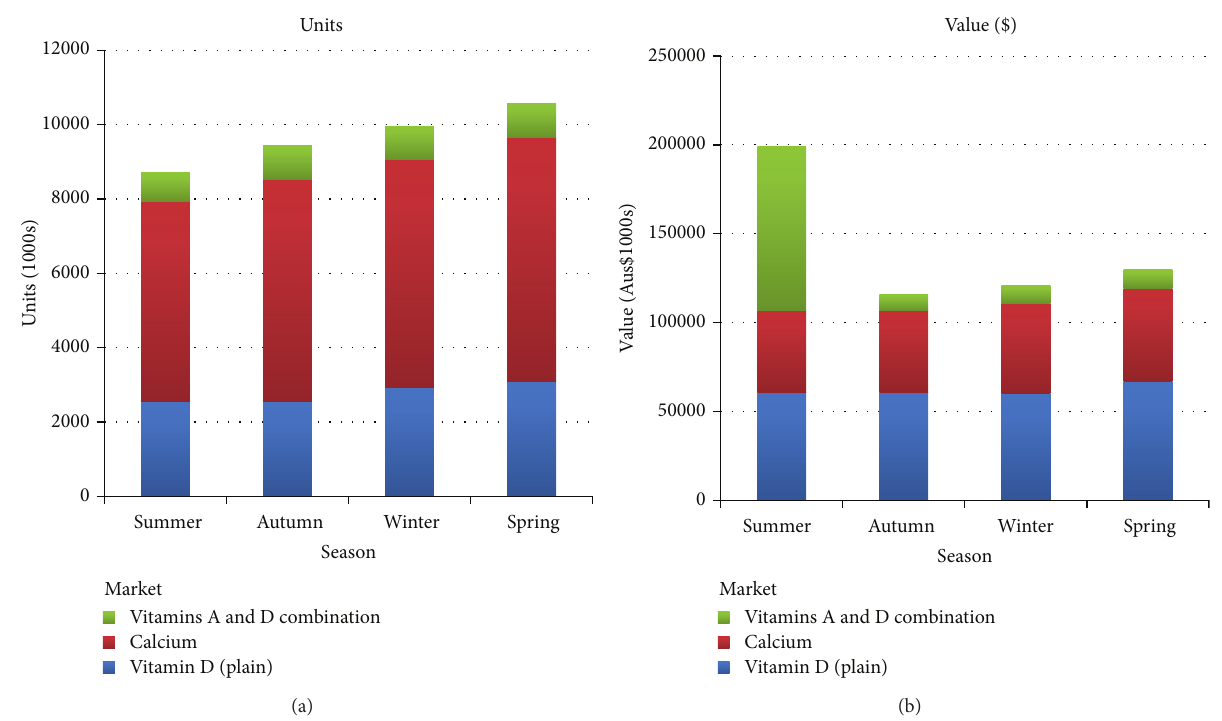
Figure 1: Total vitamin D supplement sales in thousands of units (units represent individual package as purchased from 2000 to 2010, source: IMS Health, Australia, 2012) and thousands of dollars ($Aus) from 2000 to 2010 according to season and product